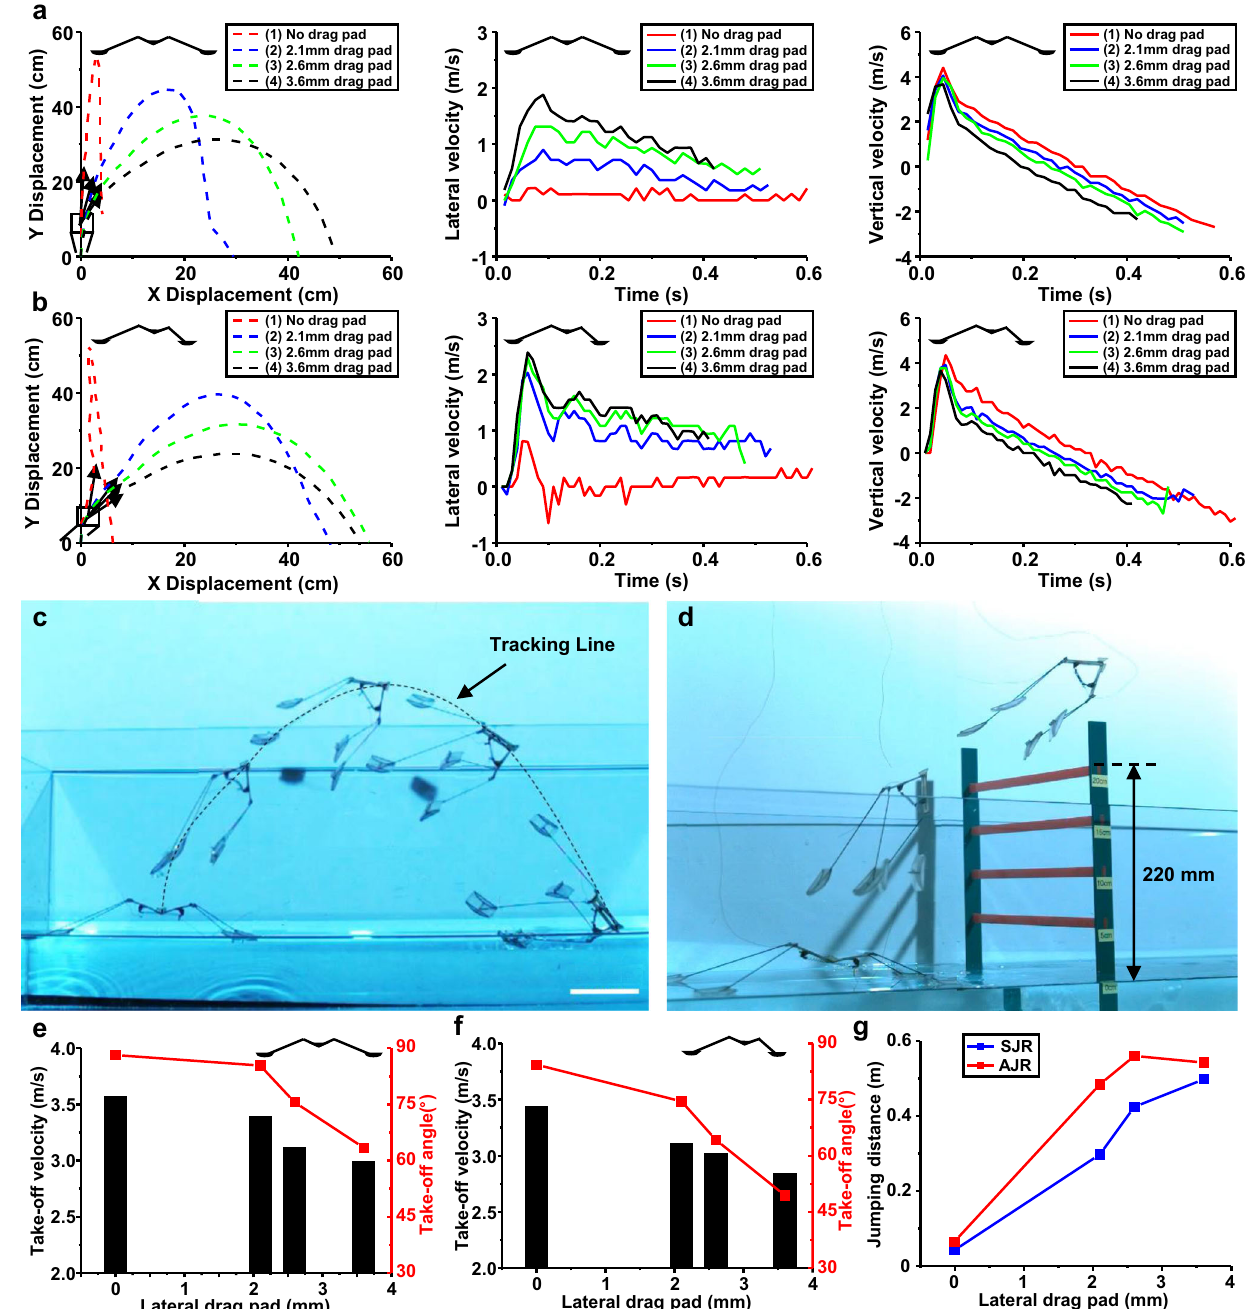
Fig. 4 | Experimental results of lateral jumping on the water surface. a , b Jumping trajectory, lateral velocity, and vertical velocity of SJR ( a ) and AJR ( b ). Therobotsaretestedbyvaryingtheheightoflateraldragpadswiththesamewidth of 20mm. c Jumping trajectory of the AJR, which attached 2.6mm drag pad. Scale